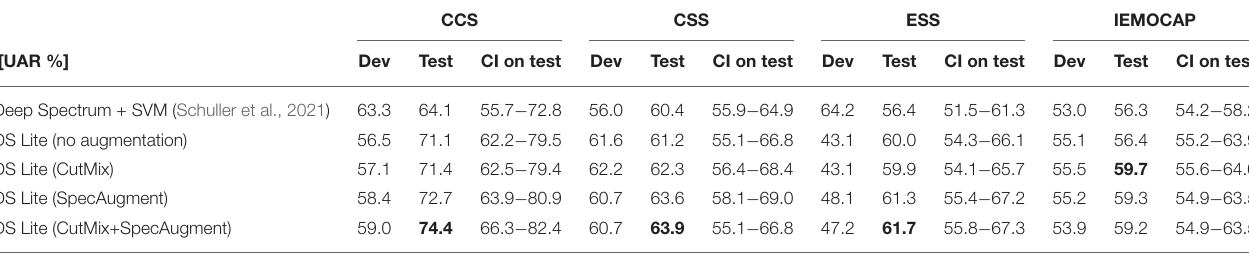
TABLE 3 | Results of the transfer learning experiments with DeepSpectrumLite (DS Lite) on three of the ComParE 2021 Challenge tasks (CCS, CSS, and ESS) and IEMOCAP compared against Deep Spectrum feature extraction + SVM. CCS CSS ESS IEMOCAP [UAR %] Dev Test CI on test Dev Test CI on test Dev Test CI on test Dev Test CI on test Deep Spectrum + SVM (Schuller et al., 2021) 63.3